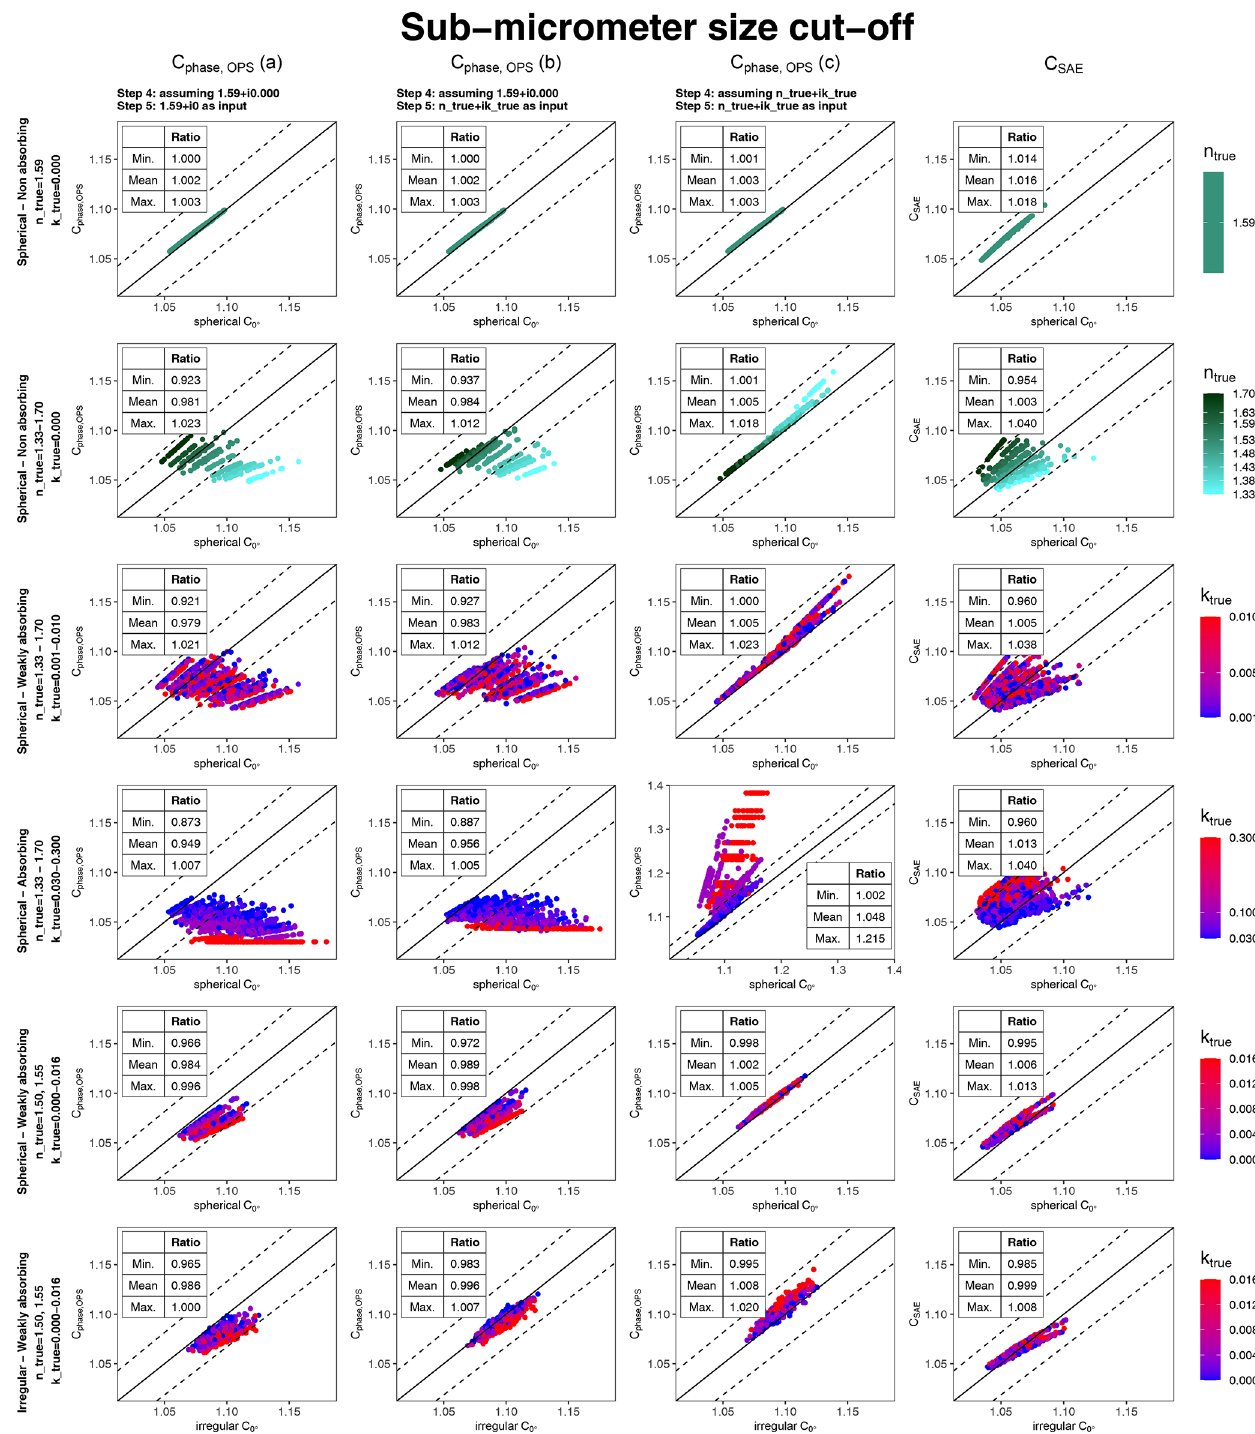
Figure 6. Simulated closure experiment to assess the limitations and uncertainties of the angular correction obtained with Mie theory from the size distribution measured by an OPS. The comparisons for the angular correction C phase , OPS calculated with the three approaches (a, b, c) are shown in the first three columns. The comparison for the angular correction C SAE is reported in the last column. Different lines refer to different aerosol input. The color code indicates different values of the real part of the refractive index for the non absorbing cases (rows 1–2) and of the imaginary part of the refractive index for all the other cases (rows 3–6). The solid lines are the 1:1 lines. The dashed lines are the ± 3% lines. The minimum, mean, and maximum value of the ratio between the quantity reported on the y axis and the quantity reported on the x axis is reported in the